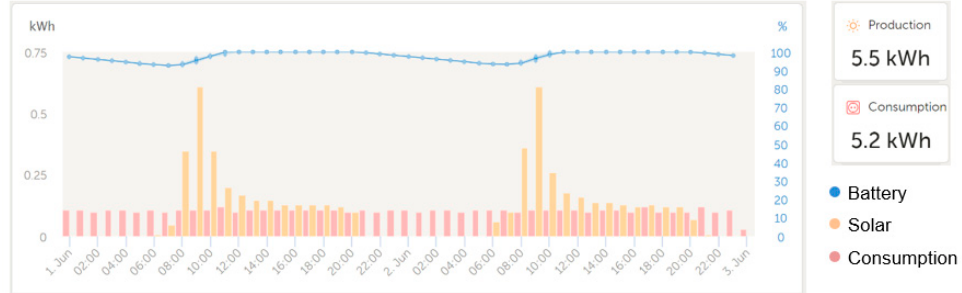
Figure 21. Energy analysis report of the LSF module, two days overview.